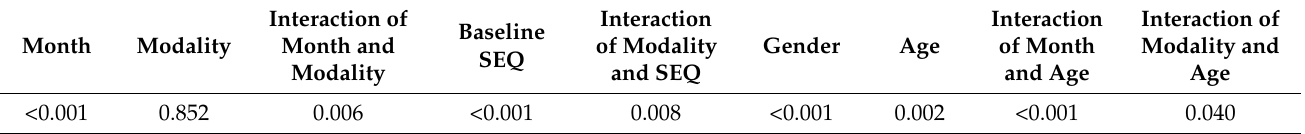
Table 3. Effect p values for a model of axial length. Modalities included in the modality effect were Atropine, OrthoK1, OrthoK234, and SMCL. The OrthoK 2, 3 and 4 variants and SMCL 1, 2, 3, and 4 variants were grouped to form the OrthoK234 and SMCL modalities. Only the OrthoK 1 variant is included in